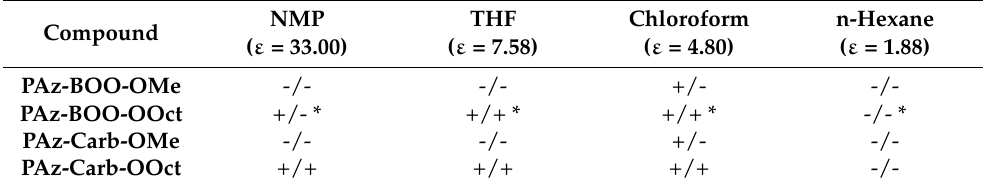
Table 1. Solubility of investigated compounds in solvents of various dielectric constants ( ε ). Compound